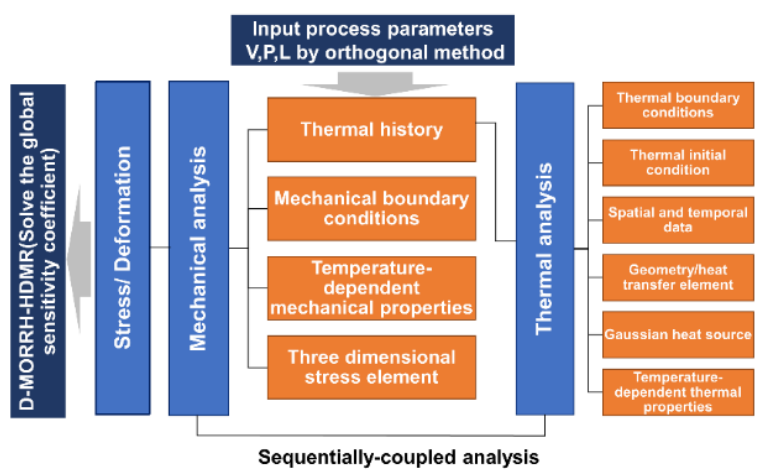
Figure 1. A block diagram summarizing the global sensitivity analysis method associated with the indirect thermal–structural coupling analysis method.